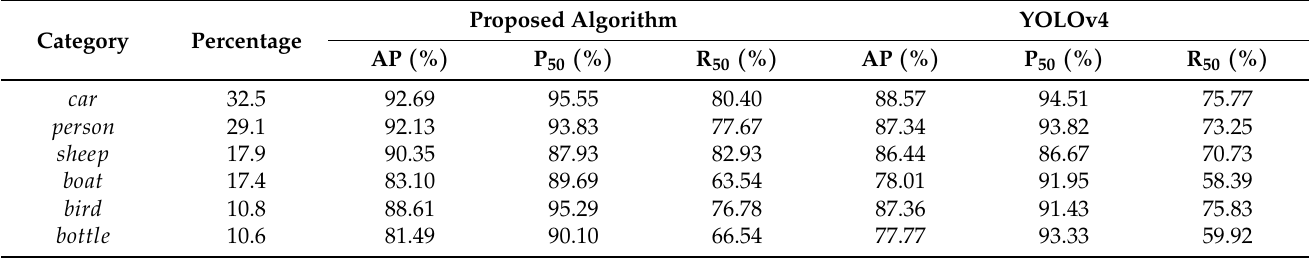
Table 2. The top 6 categories in the test sets with the average accuracy of small